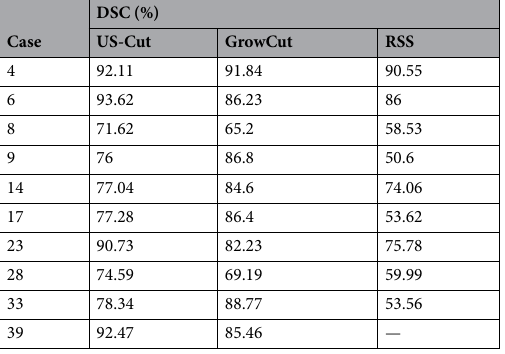
Table 2. Direct comparison for the four cases where our approach could achieve a DSC higher than 90% and the six cases where our approach achieved a DSC lower than